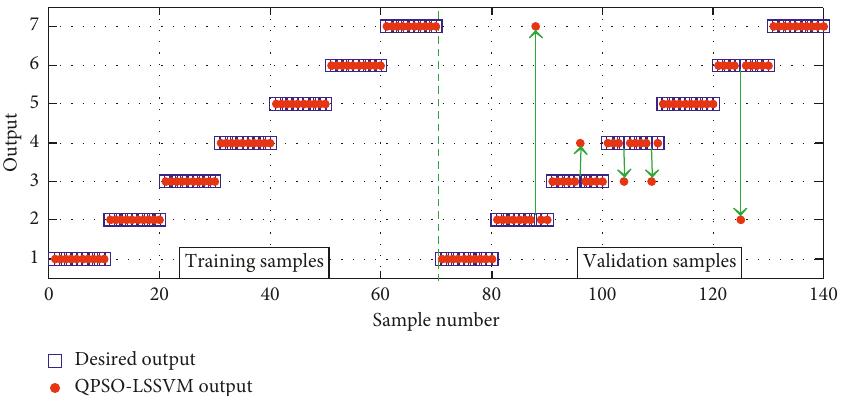
Figure 14: Classification results of the PSO-LSSVM model based on ASD parameters.